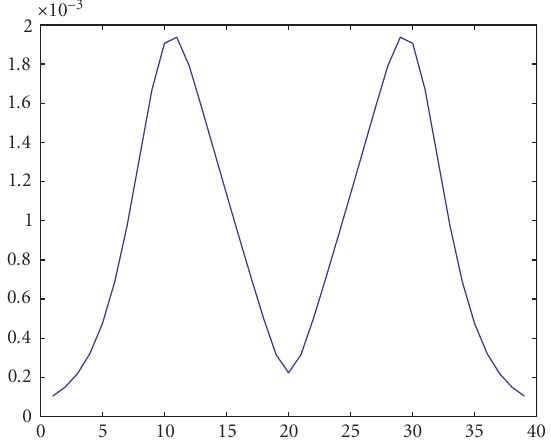
Figure 2: Likelihood function p ( z | x ) for acoustic amplitude sen- sors. The circle is the sensor location ζ and the cross is the true tar- get location. Figure 3: The cross section of the likelihood (plotted in Figure 2) along the horizontal line past the sensor